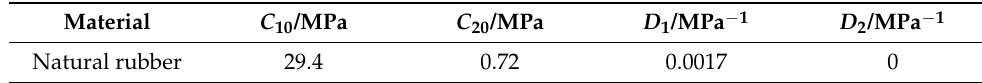
Table 2. Table of intrinsic rubber parameters.